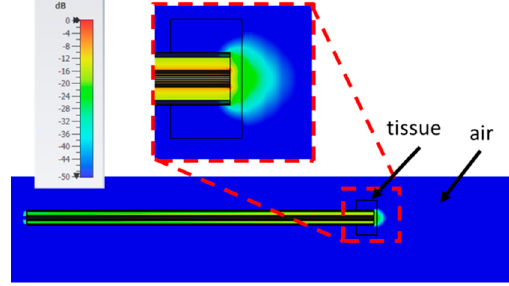
Figure 11. RMS electric field at 0.5 GHz evaluated in the fat in the reference case (70, 15, 20, a). Colour scale in dB max (0; − 50 dB).